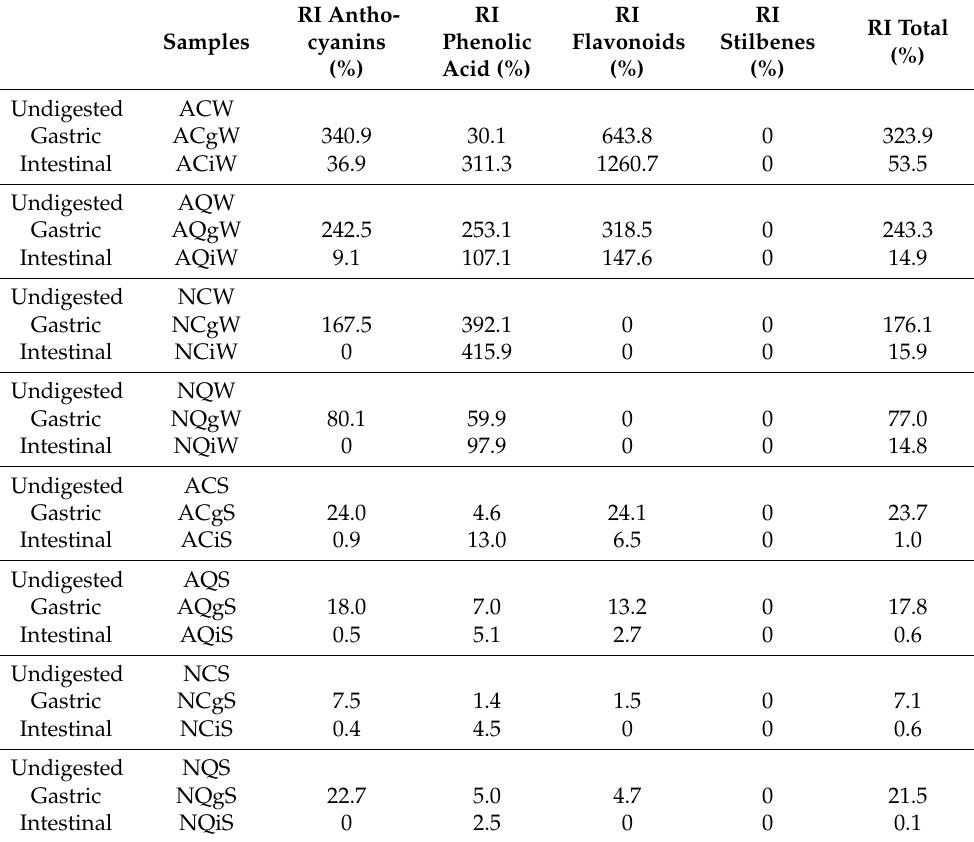
Table 3. Recovery Index % (RI) of each phenolic group (anthocyanins, phenolic acid, flavonoids, stilbenes and total) in samples extracts before (undigested) and after in vitro digestion (gastric- and